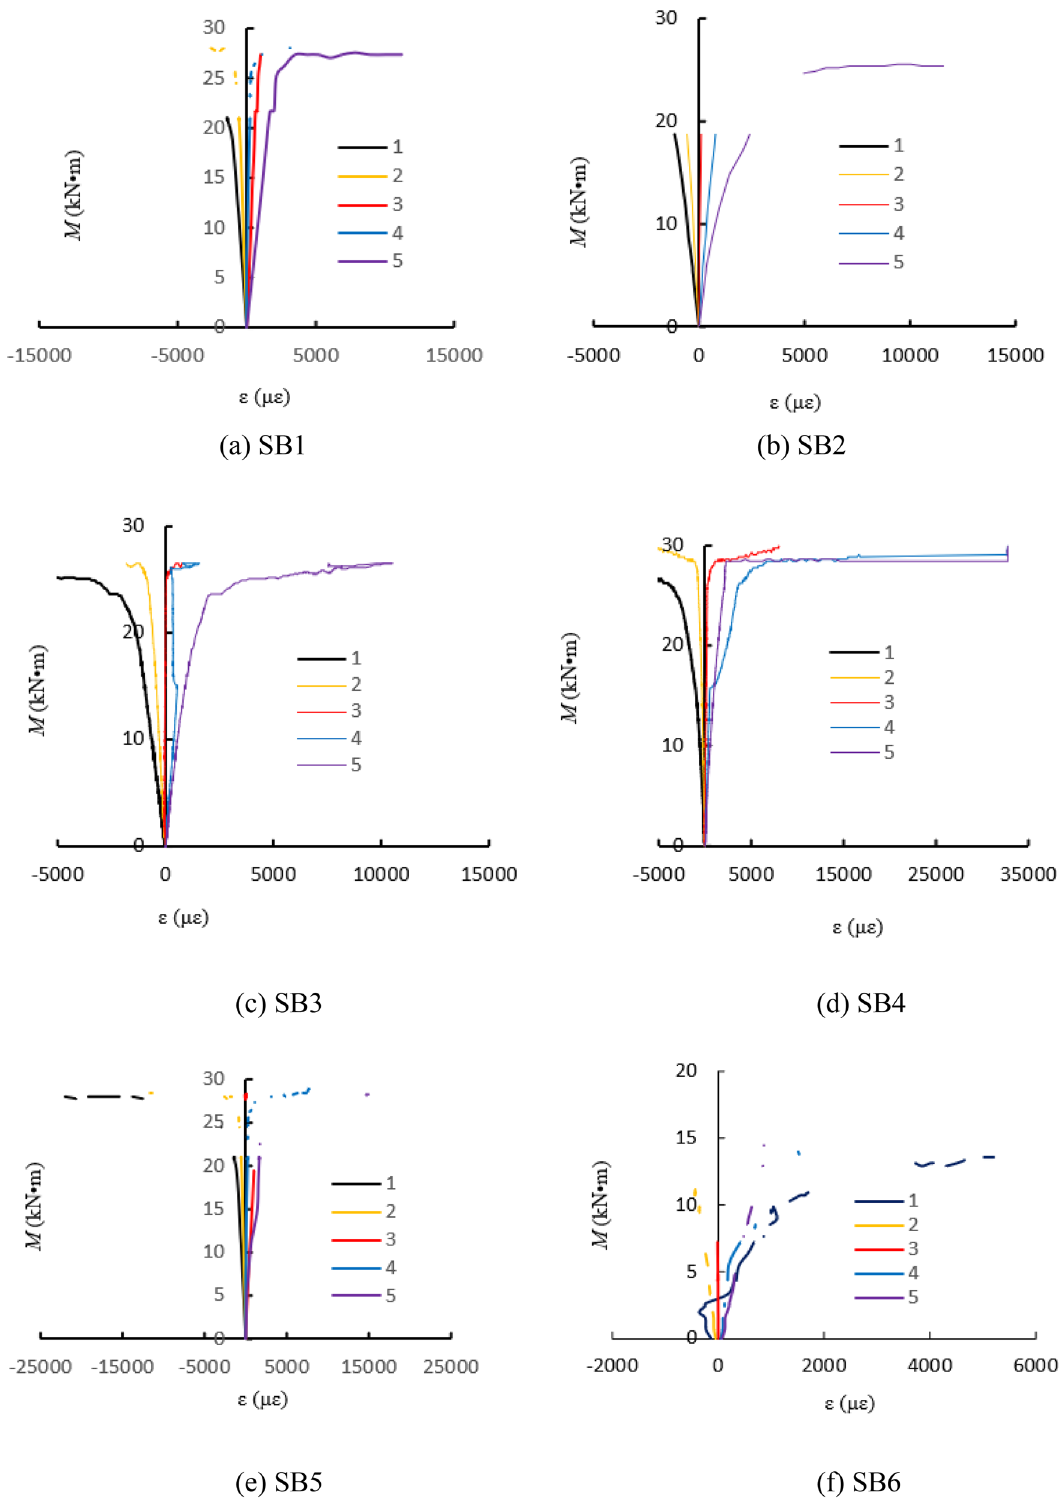
Figure 7. Bending moment-strain curves of